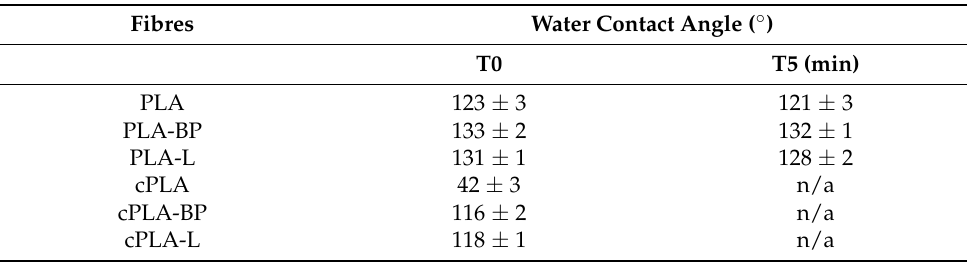
Table 2. Mean values of the contact angle at T0 and T5 for PLA, PLA-BP and PLA-L fibres, before and after the CS coating (mean values ± s.d.; n = 3).